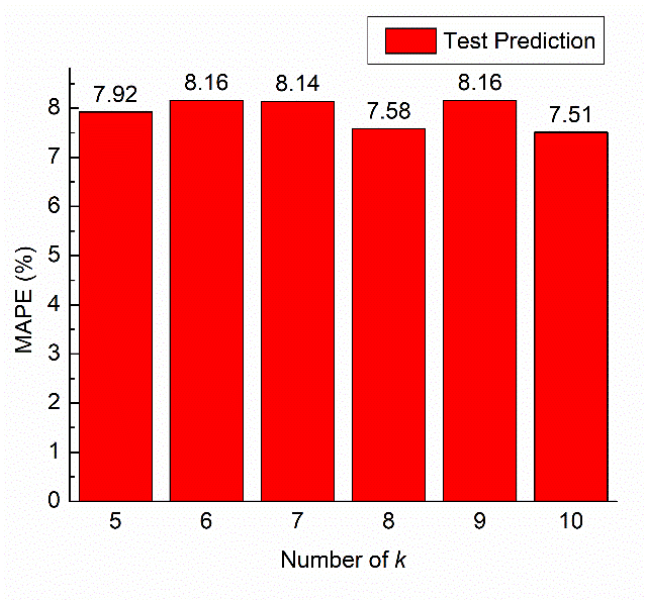
Figure 7. Average MAPE for various k